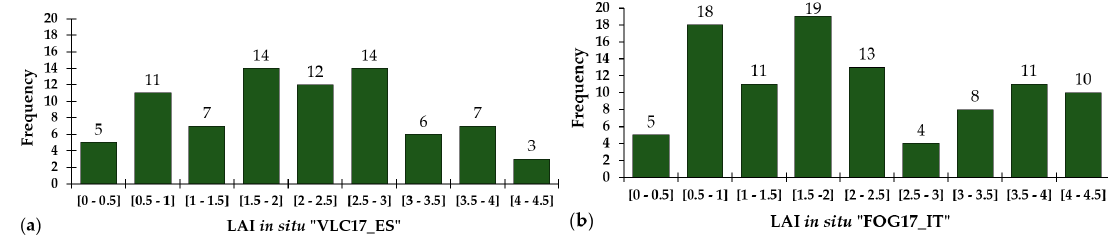
Figure 3. ESUs frequency histogram classified for LAI green value range, for ( a ) the VLC17_ES testing dataset and ( b ) the FOG17_IT validation dataset. Bare soil ESUs are not included.